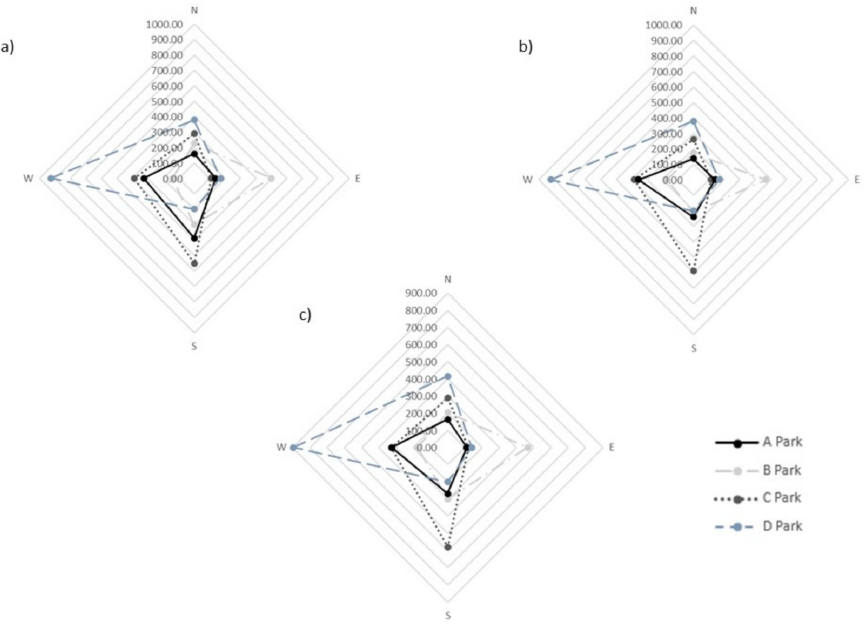
Figure 5. Radar diagrams of the distance (in meters) of the park’s cooling influence on surrounding LST for ( a ) 2017, ( b ) 2018, ( c ) 2019.